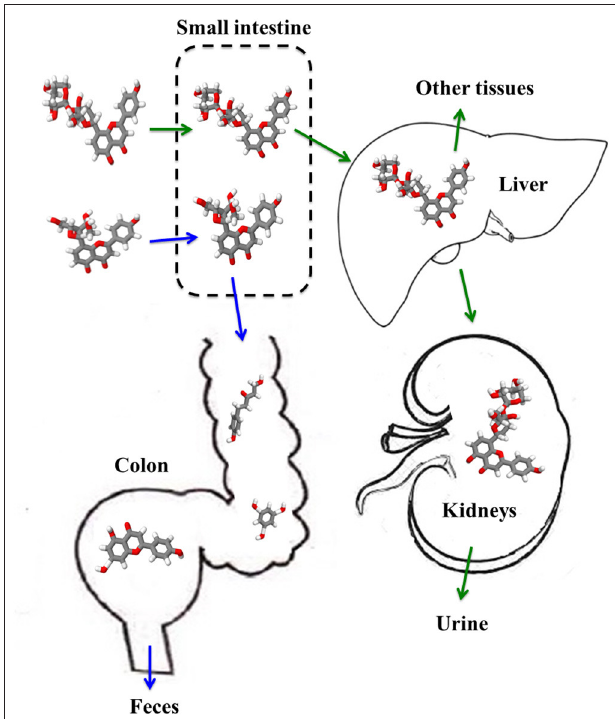
FIGURE 4 | Biotransformation of flavone C -monoglucosides and flavone C -multiglycosides into different flavonoid aglycones, monomers and dimers in various organs and tissues, and their subsequent excretion. The depicted pathway though simplified, does not reflect the complexity of polyphenols absorption, transport, and